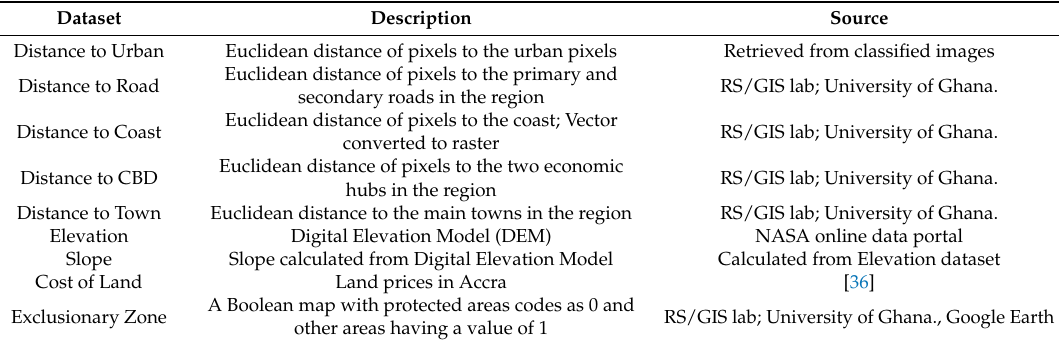
Table 3. Driver variables used and their